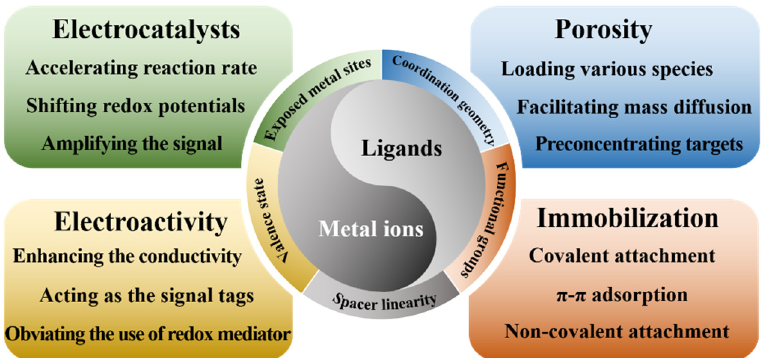
Scheme 1. Schematic illustration of the relationship of building blocks (metal ions and ligands) with the functions of